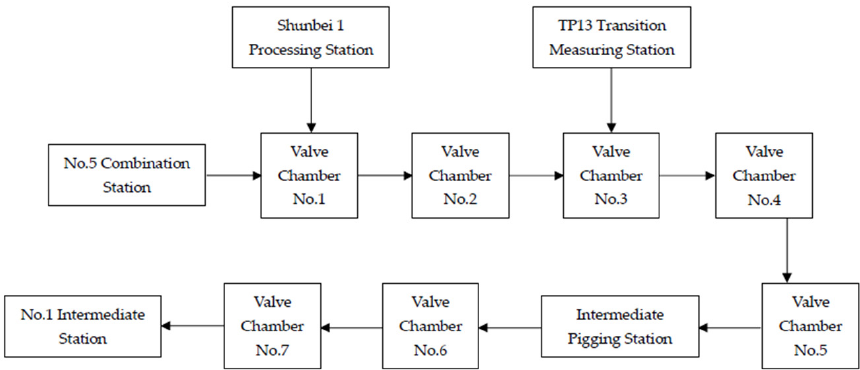
Figure 1. Schematic diagram of the direction of the Shunbei crude oil pipeline. The overall design transportation scale of the pipeline is 1.8 million tons/year. The Shunbei 1 processing station and the TP13 transition measuring station are equipped with crude oil insertion points. The crude oil transportation throughput of each station is shown in Table 1. The annual production time is considered to be 350 days. The pipeline adopts the closed and unheated transportation process, and the buried part of the line is not insulated. The lowest average ground temperature at the buried depth of the pipeline is 5 ◦